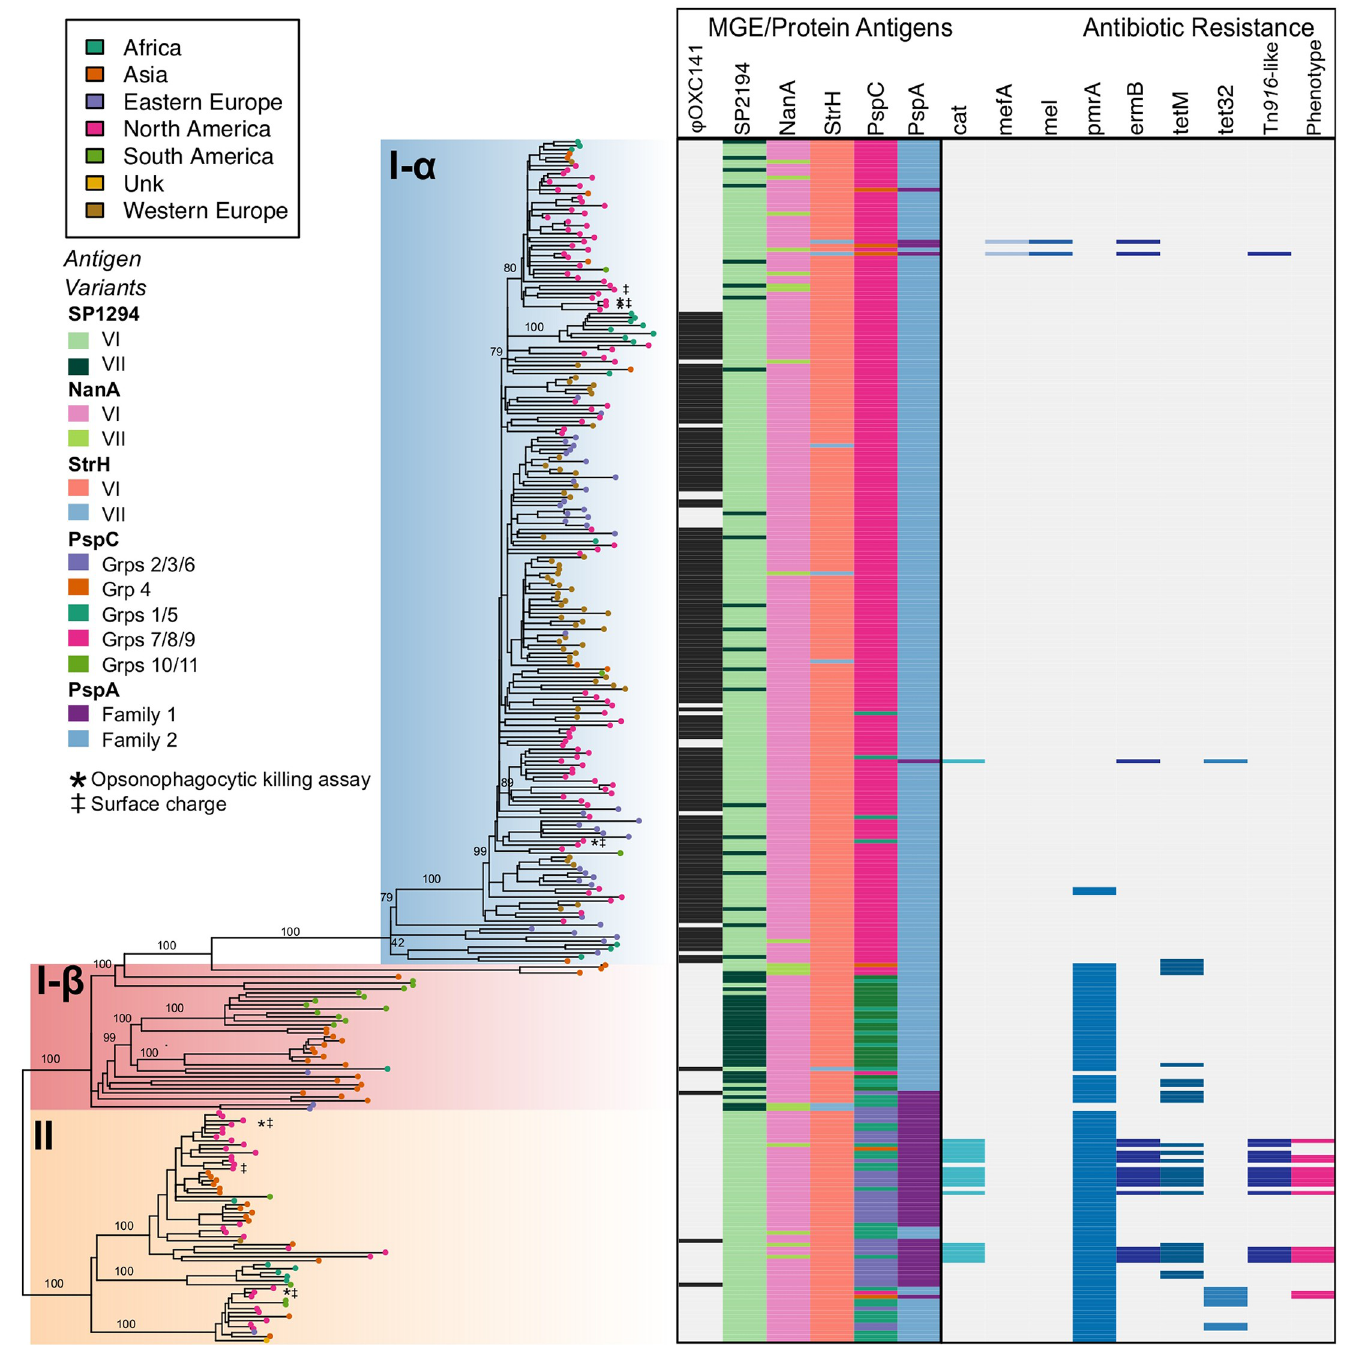
Fig 5. Phylogeny, polymorphic protein antigen variants, and antibiotic resistance. Midpoint rooted maximum-likelihood phylogeny corresponding to Fig 2A with geographic region of isolation represented as colored tip shapes. Clades I- α , I- β , and II are shaded consistent with Fig 2A. Bootstrap values from 100 replicates are provided for major clades and sub-clades (see supplemental phylogeny for all values). Strains used in opsonophagocytic killing assay (asterisk) and surface charge experiments (double dagger) are indicated on the phylogeny. Corresponding protein antigen variants for SP1294, NanA, StrH, PspC, and PspA are illustrated on the left half of the heatmap. Eight other protein antigens are excluded due to a lack of variation in the sample. The presence and absence of AMR-associated genes are illustrated on the right half of the heatmap. The last column of the heatmap indicates genotypic antibiotic resistance that was confirmed by phenotypic testing (broth dilution or disk